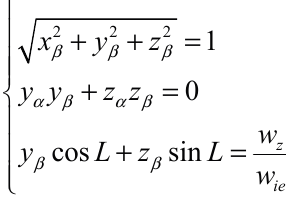
Table 2. The four possible sets of six inertial measurement unit (IMU) outputs calculated with f , w , and w used for selective alignment according to Equations (22) – (24). y y z Angular Velocity ( 4 10 rad/s − ) Specific Force ( 2 m/s ) w f w w f y y x z x